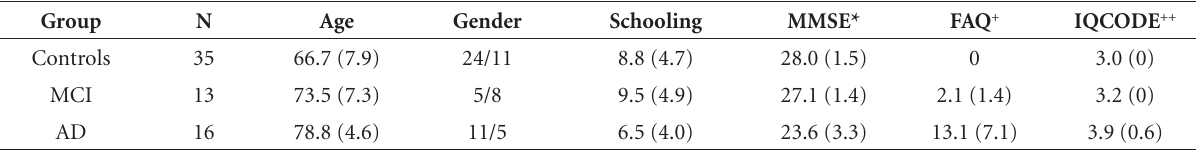
Table 1. Sample descriptive data.